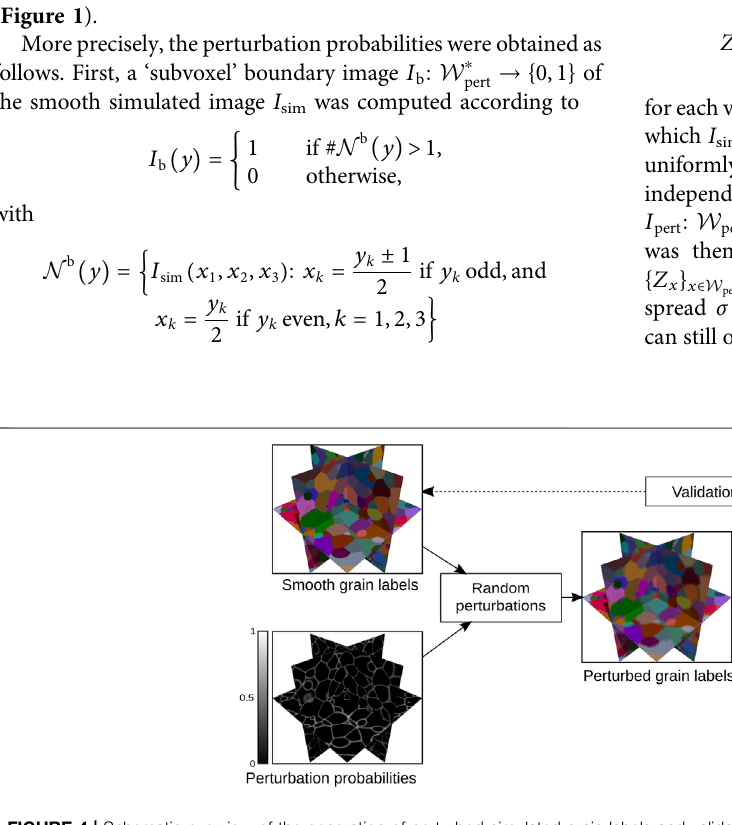
Frontiers in Materials |